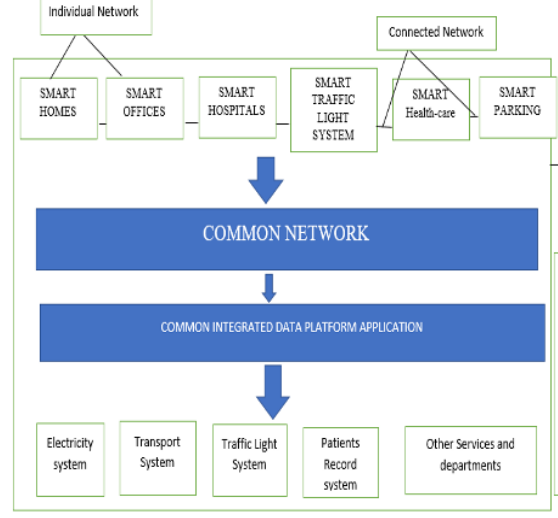
Figure 2 . IoT services and